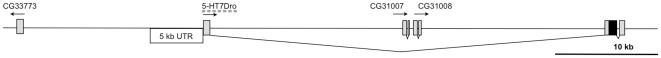
Map of 5-HT7Dro region.The 5-HT7Dro locus on the third chromosome is
approximately 40 kb with a large first intron that contains two
additional short annotated transcripts. The 5 kb region of genomic
DNA immediately upstream of the mRNA transcript start site used to
generate the 5-HT7Dro GAL4 strain is shown (white box).
Grey boxes indicate untranslated regions of exons, darker boxes
represent translated regions. Arrows indicate direction of
transcription. Scale bar is shown.